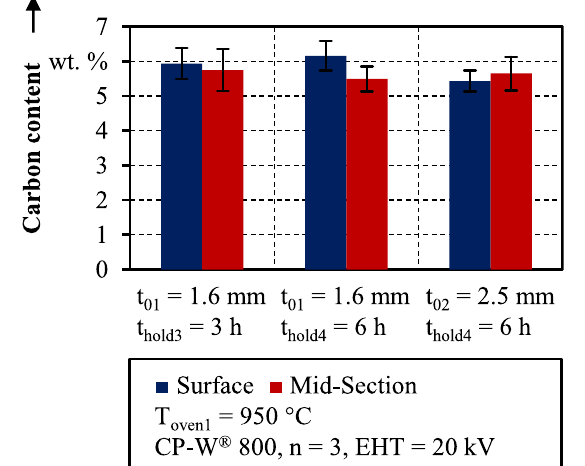
Fig. 11. Carbon content of samples carburized at 950 ° C measured via EDX